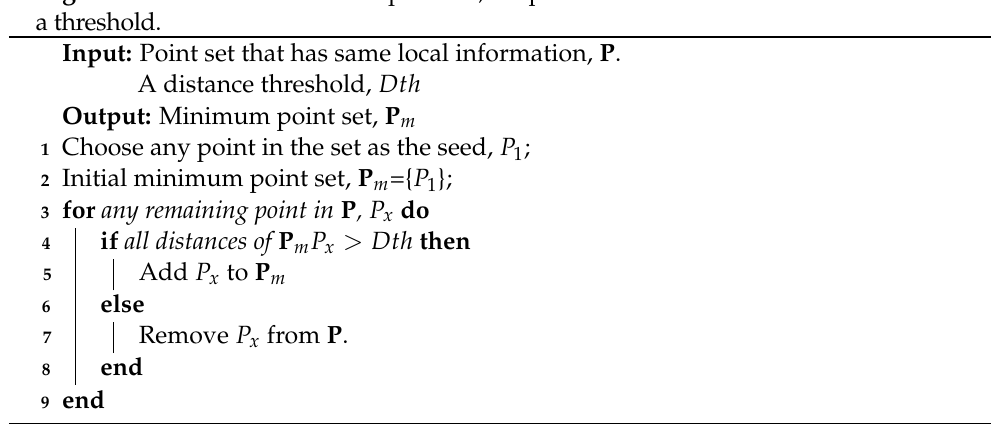
Algorithm 1: Find the minimum point set, the pairwise distance of which is above a